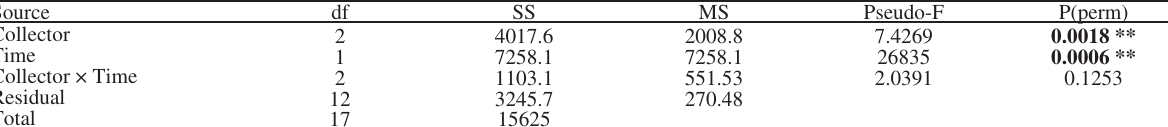
Table S3. – Results of the two-way permutational analysis of variance (PERMANOVA) performed to identify significant differences in the number of A. lixula settlers/m 2 between the factors ‘Collector’ and ‘Time’ at the Canary Islands site (Abades). Significant results are shown in bold (* p<0.05; ** p<0.01).